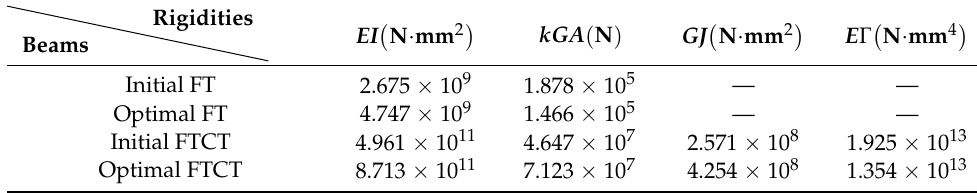
Table 3. Rigidities optimized by GA.